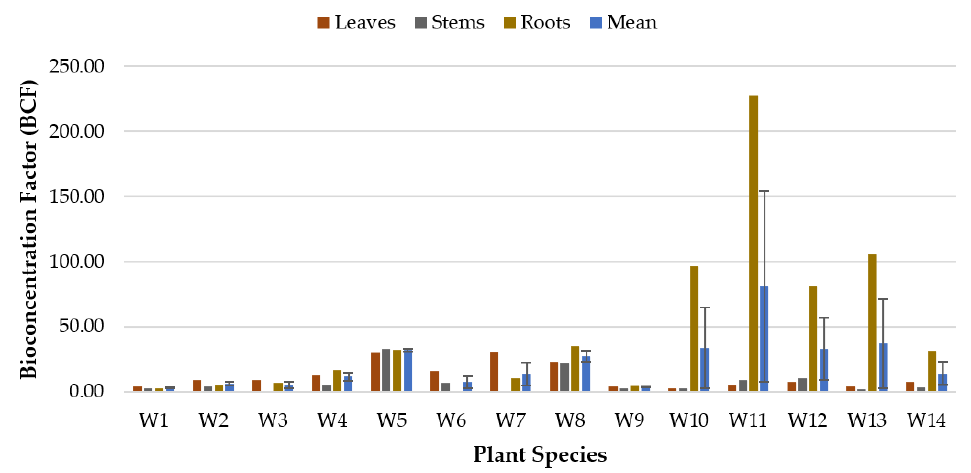
Figure 5. Bioconcentration factor (BCF) of magnesium (Mg) in the phytoremediation of domestic sewage mesocosms using various tropical plants.